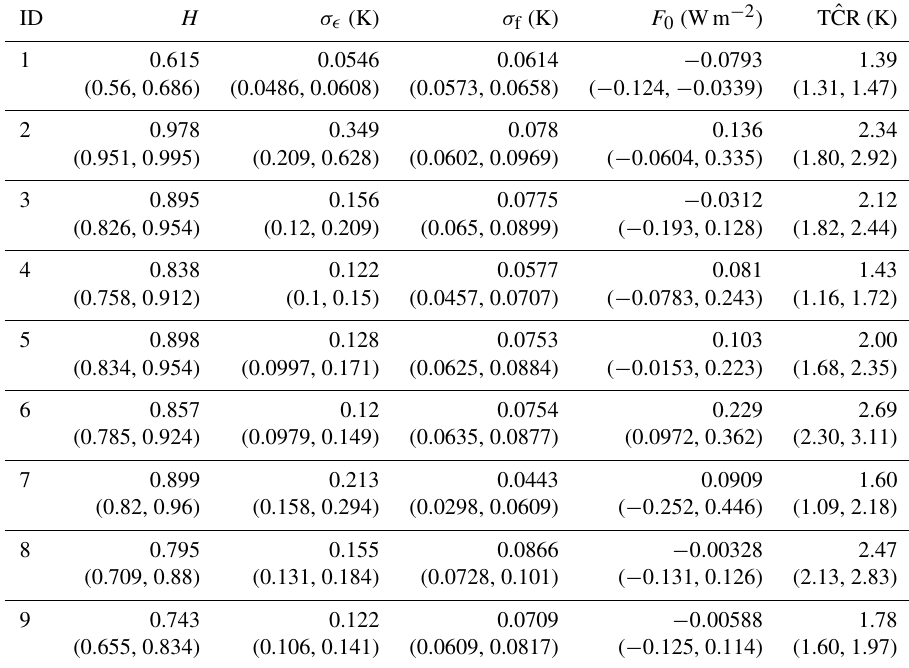
Table 3. This table contains marginal posterior means and 95% credible intervals for the model parameters and the transient climate response obtained from fitting the scale-invariant response model to temperature data from the first nine